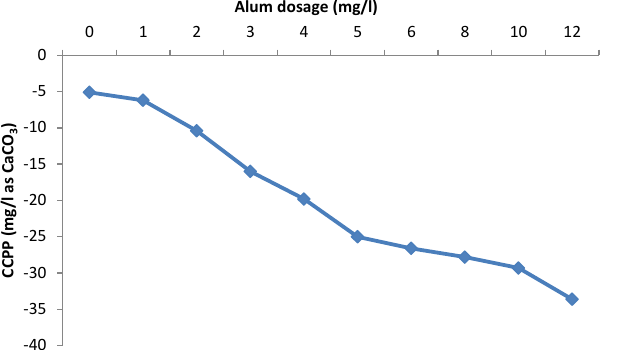
Equilibration of